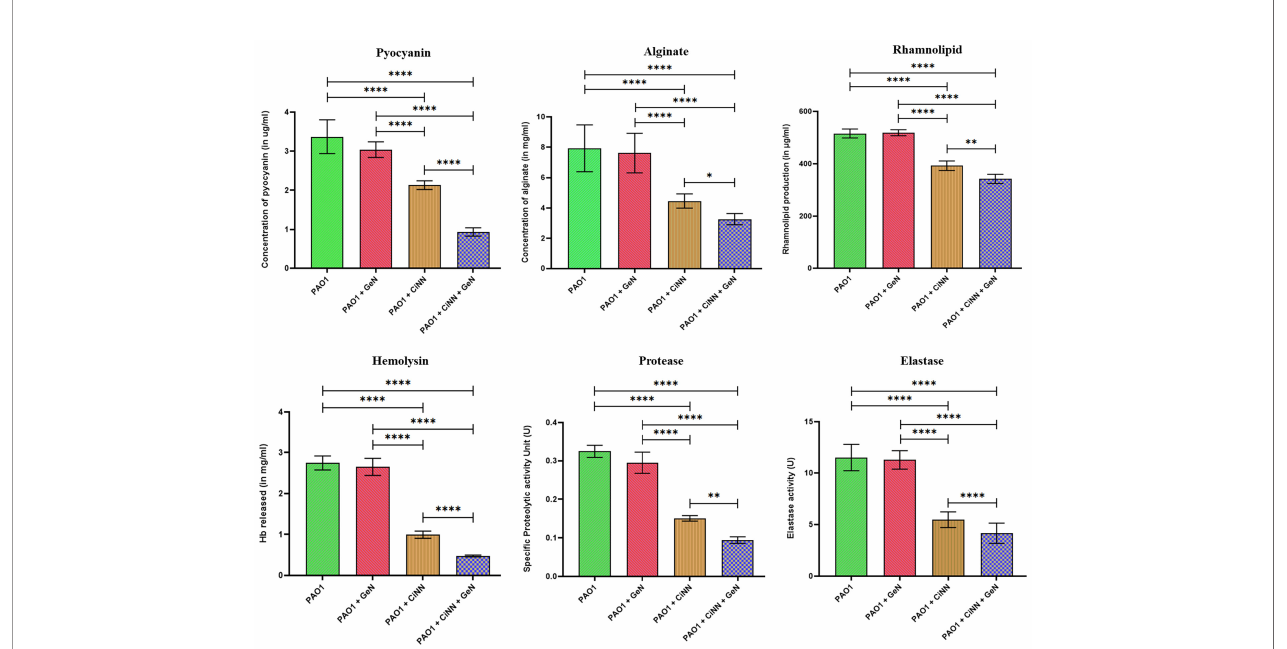
FIGURE 6 | Anti-virulence effects of sub-MICs of CiNN and GeN against P. aeruginosa PAO1, alone and in combination. Various QS-regulated virulence factors including, pyocyanin, alginate, rhamnolipid, hemolysin, protease, and elastase production were assayed in the presence and absence of the drugs. (*p ≤ 0.05, **p ≤ 0.01, ****p ≤